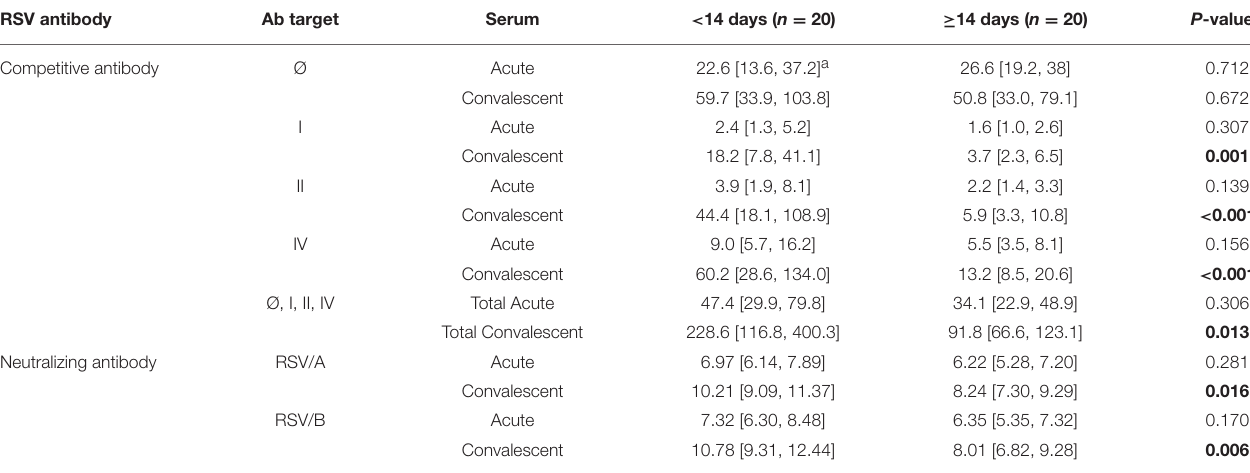
a Geometric mean conc., µ g/mL for competitive antibody and log2 for neutralizing antibody titer [95% Confidence Interval]. b Two-sample t-test for difference in means of antigenic site competitive antibody conc. (log2 µ g/mL) or neutralizing antibody titer (log2) between < 14 and ≥ 14 days. The bold values significant means that the p-values are statistically significant at 0.05